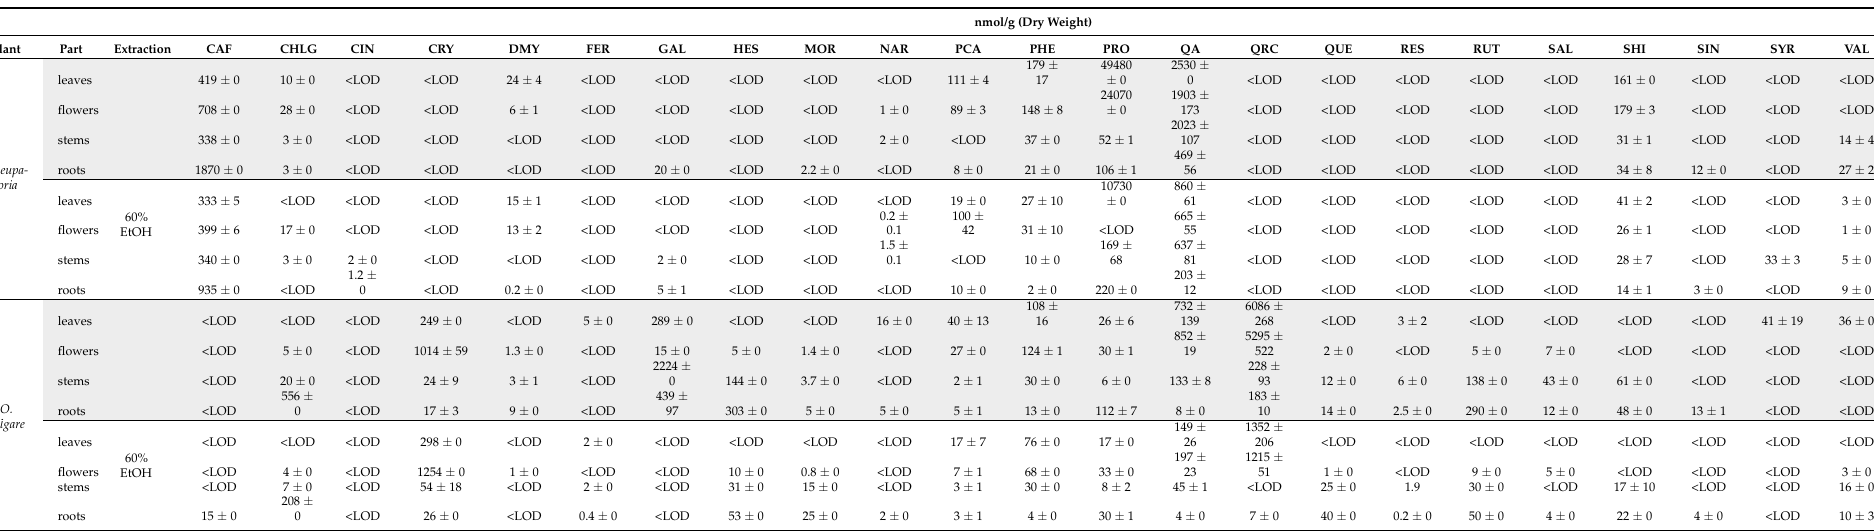
Table 2. Analysis of secondary metabolites in A. eupatoria and O. vulgare extracts prepared in water or 60% ethanol. The quantity is expressed as nmol per gram of dry plant